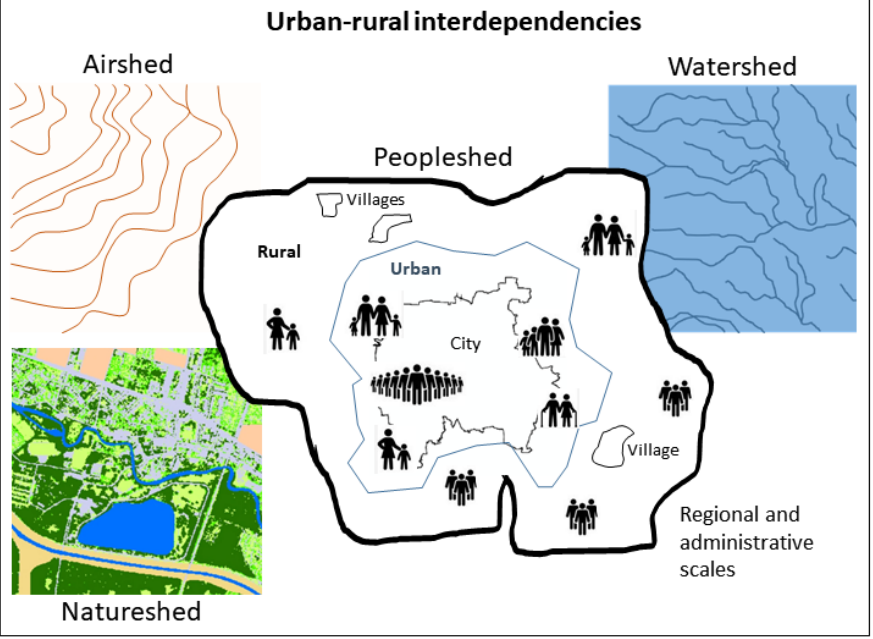
Figure 4. Interdependencies of various “sheds”. Own sources .